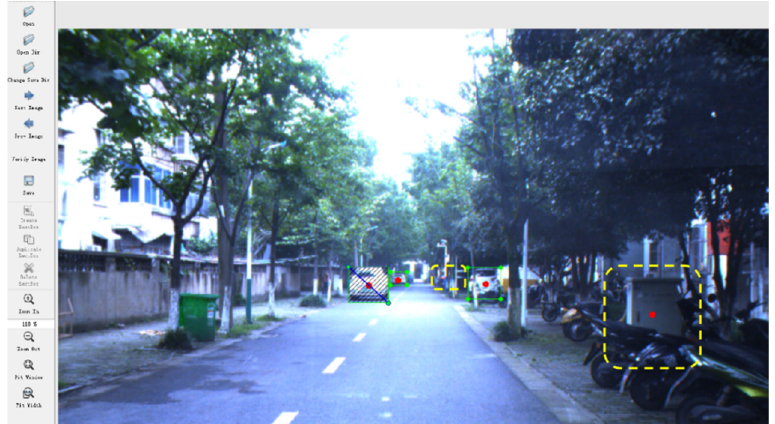
Figure 18. Annotation of ground-truth labels.